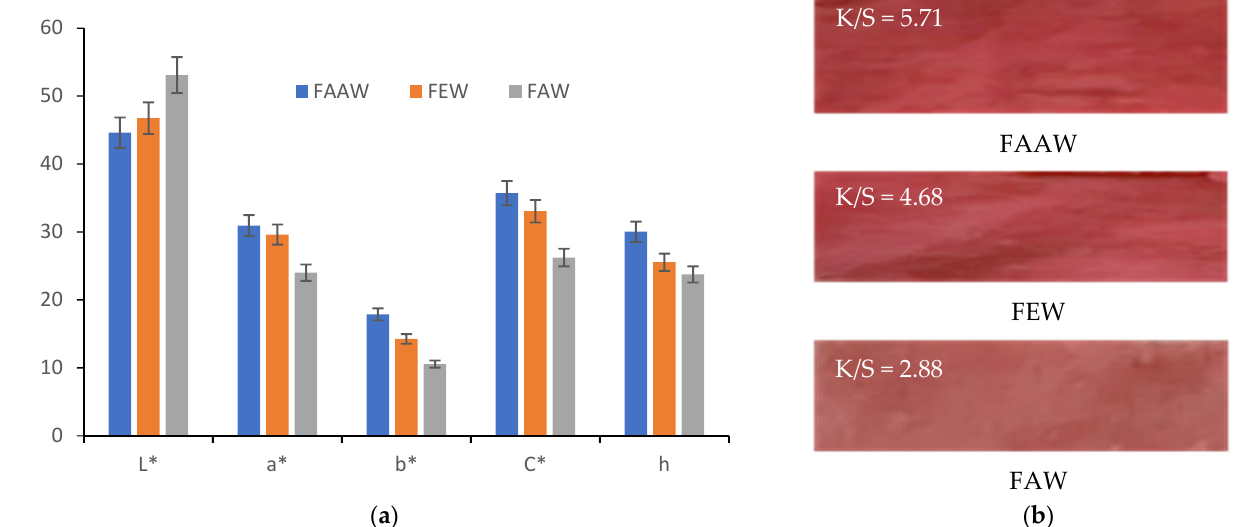
Figure 5. Characterization of the colors resulting from the functionalization and dyeing of the wool: ( a ) CIEL*a*b* measurements; ( b ) color strength (K/S).